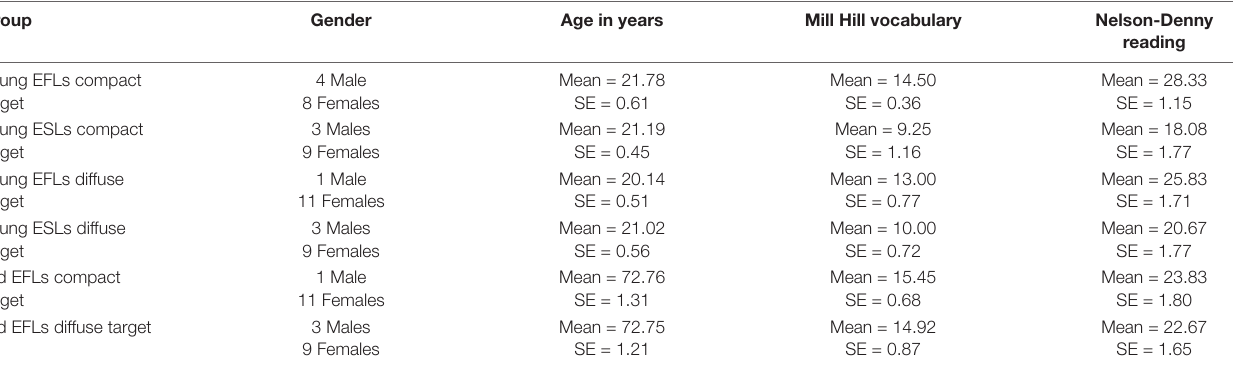
TABLE 2 | The gender breakdown, mean age, Mill Hill vocabulary test and Nelson-Denny reading comprehension test results for the Young-EFL (taken from Avivi-Reich et al., 2020), and for the Old-EFL and the Young-ESL participants in this experiment. SE stands for Standard Error.